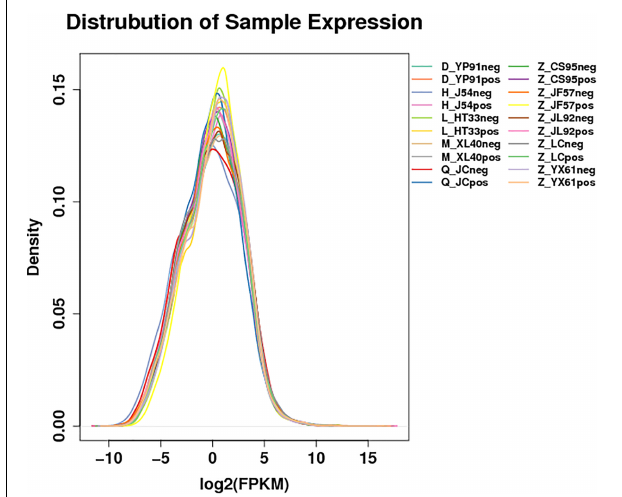
FIGURE 1 | Expression profile of lncRNAs. Distribution map of the expression profile: For the gene expression of each group of samples, the density distribution was made after taking the logarithm of base 2. The horizontal coordinate was log2 (FPKM + 0.0001), and the ordinate was the density of genes. Different colors represent different